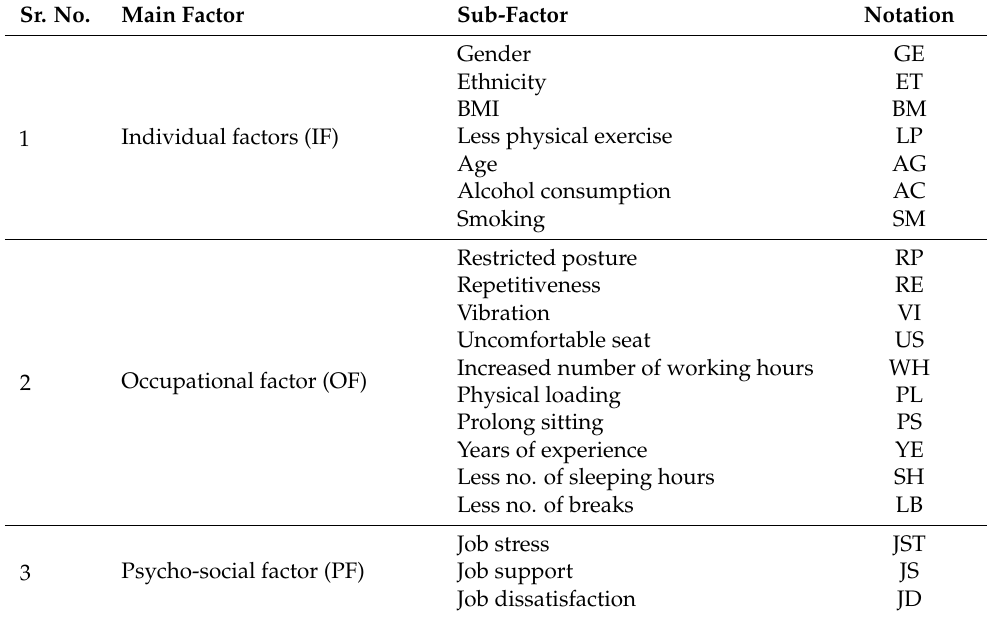
Table 2. The hierarchical structure of MSDs’ risk factors.